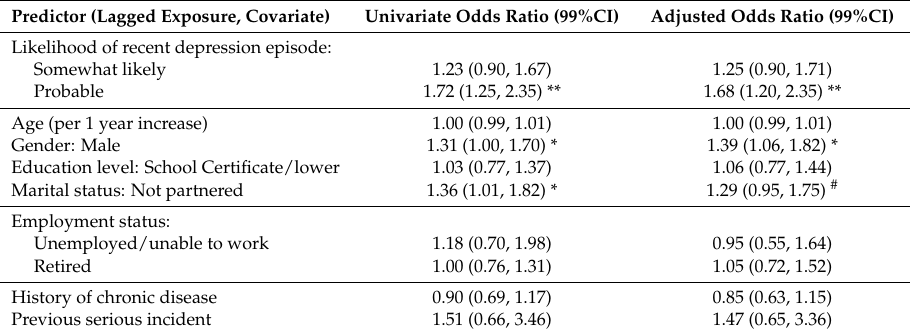
Table 3. Univariate and multivariate logistic regression results, showing longitudinal associations of the lagged exposure and individual covariates with subsequent injury: Complete case analysis ( N = 3669 exposure-outcome combinations, from 1754 unique